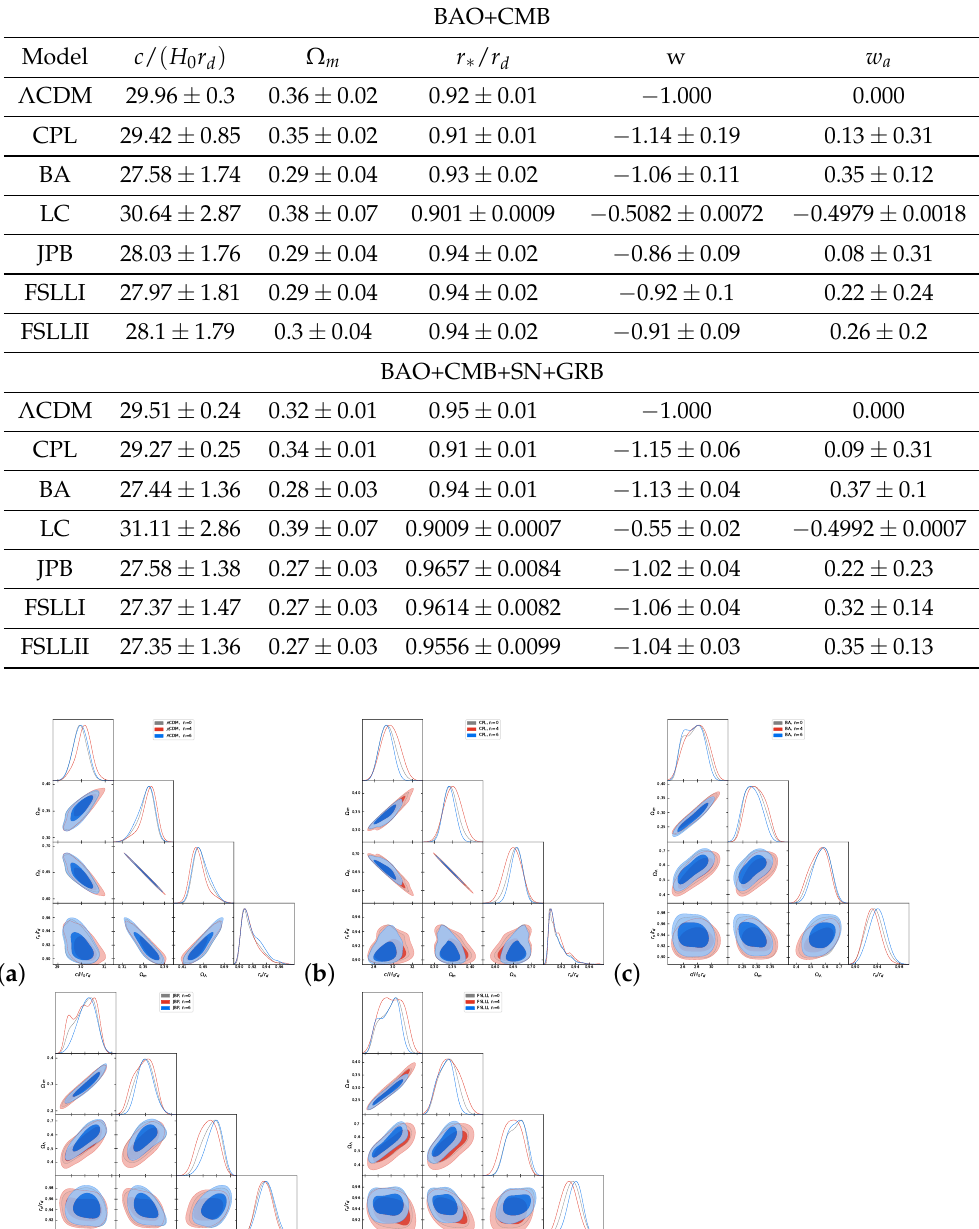
Table A3. The posterior values for c / ( H 0 r d ) , Ω m , r ∗ / r d and w 0 , w a for different parametrization of DE for the BAO+CMB dataset (top) and for the BAO+CMB+SN+GRB (bottom).